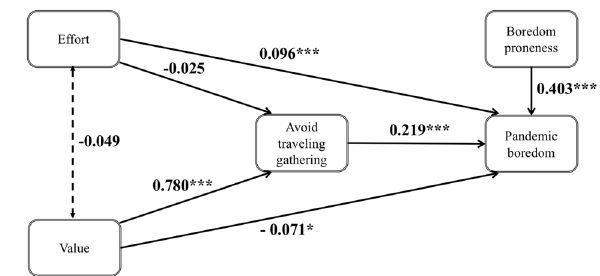
Fig. 2 Thanksgiving model. Coef fi cients are unstandardized. ***Difference is signi fi cant at the 0.001 level (two-tailed) and *Difference is signi fi cant at the 0.05 level (two-tailed). N =